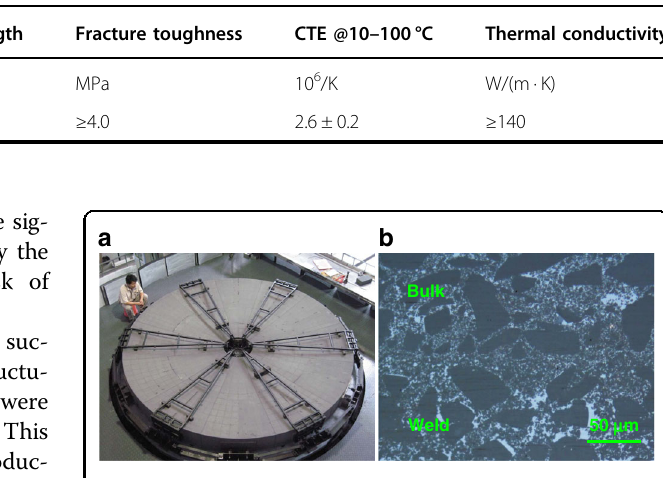
Table 2 Material properties of ⌀ 4.03 m SiC mirror